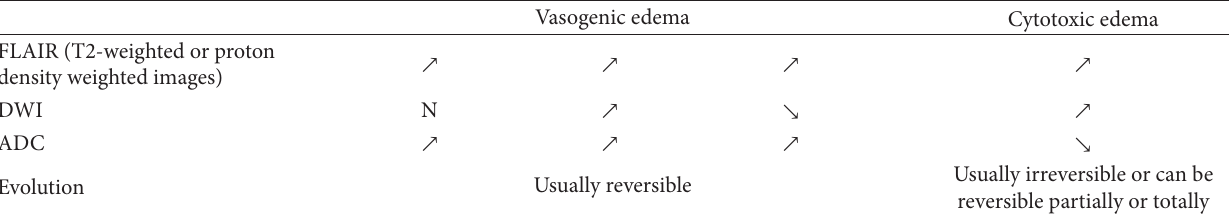
Figure 2: MRI evolutions in Patient 1. (a) Deep white matter vasogenic edema. (b) Incomplete regression of vasogenic edema with cytotoxic edema in corpus callosum and parietal regions. (c) A remarkable resolution of vasogenic/cytotoxic edema. Table 2: MRI alternations of vasogenic and cytotoxic edema in TAC-E. Vasogenic